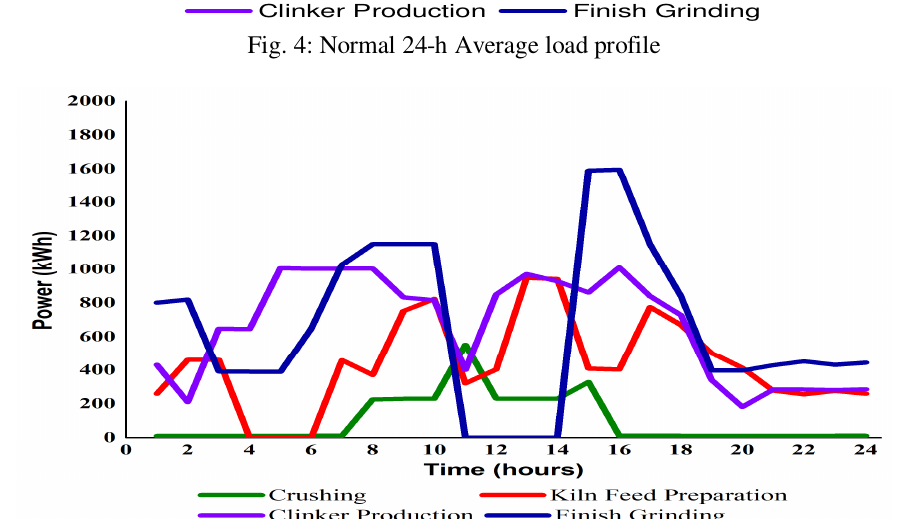
Fig. 4: Normal 24-h Average load profile